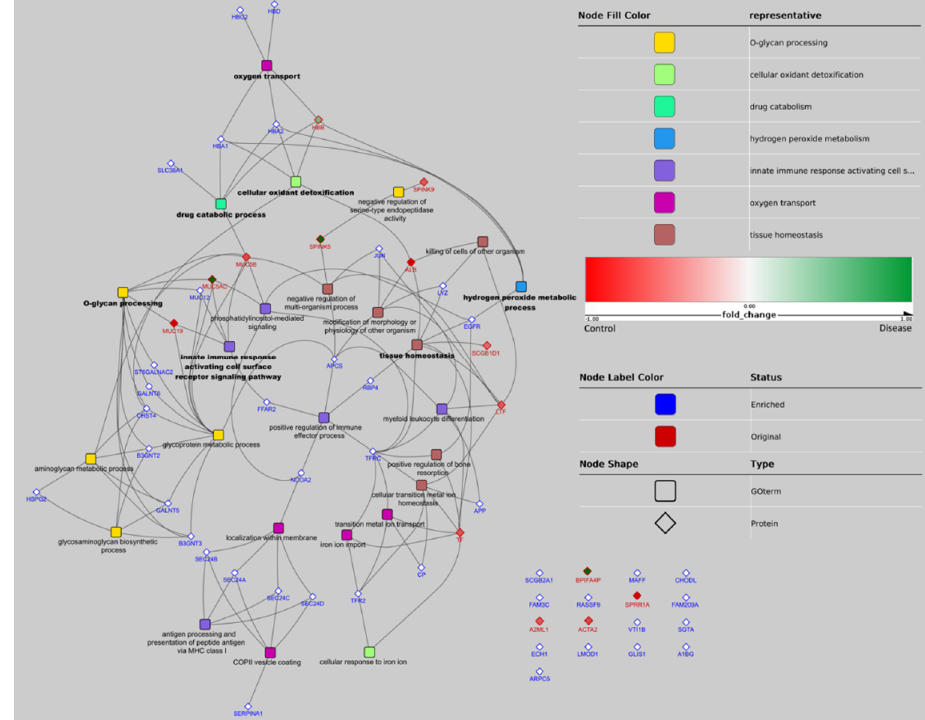
Figure 2. Network representation of GO terms over-represented in the pool of significant proteins and associated proteins. GO terms are represented by a rounded rectangle shape, proteins by a diamond shape. Proteins identified in the experiments have a red border and proteins added by the enrichment step have a blue border. GO nodes are filled by colors corresponding to their GO group (determined by ReviGO). Names of GO terms defining 1 group are in bold. When a protein belongs to 1 GO term, a link is figured between the nodes of the protein and GO term. The net- work representation has been realized with Cytoscape using the radial layout. Gene acronyms and related full name protein of each protein that appears in the figure (data obtained from UniProt database; (http://www.uniprot.org, accessed on 1 October 2018): (1) Mapped original